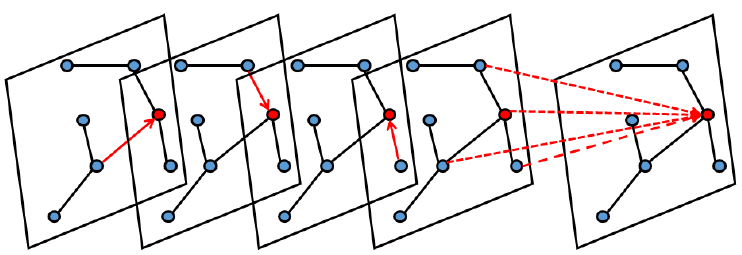
Figure 8. Topological relationship between gantry to obtain spatial feature expressway.